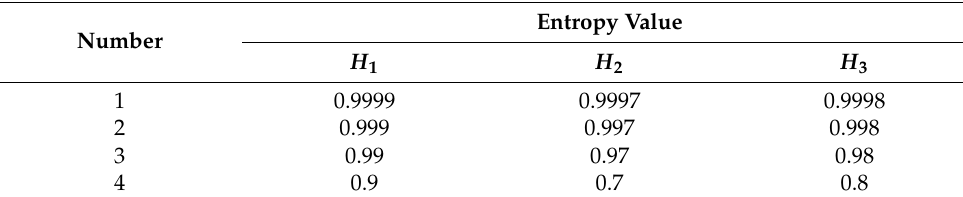
Table 1. Information entropy values for weight calculation.